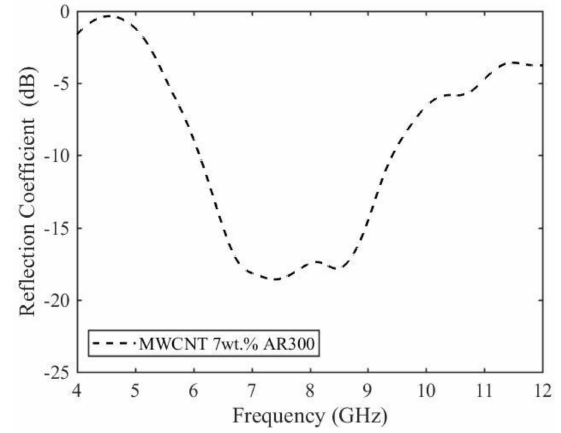
Figure 10. Reflection coefficient for the AR300